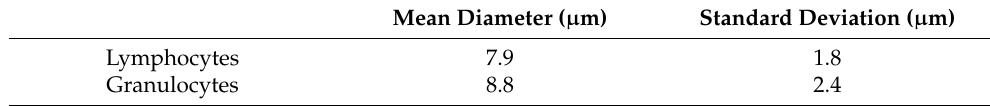
Figure 1. Images of lymphocytes ( a ) and granulocytes ( b ) obtained with the optical microscope from 3000 cells/ µ L suspensions in the Neubauer haemocytometer. Examples of size diameter histograms corresponding to lymphocytes ( c ) and granulocytes ( d ) with a Gaussian fitting superimposed. Table 1. Mean diameter and standard deviation of lymphocytes and